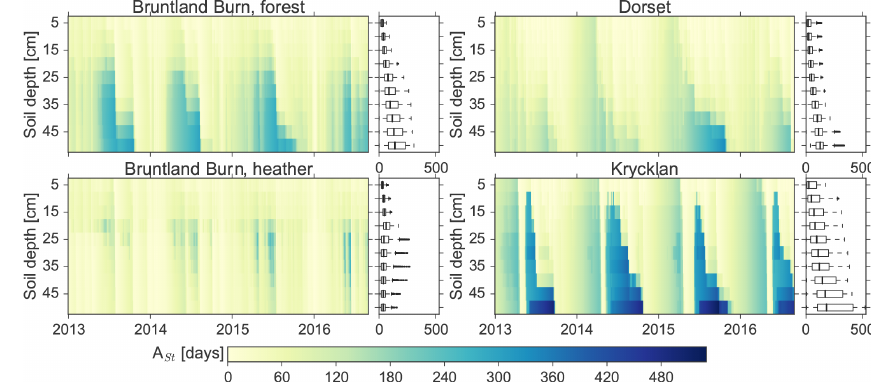
Figure 7. Median water age of the total soil water ( A St ) at 5cm intervals over the simulation period for each of the study sites.